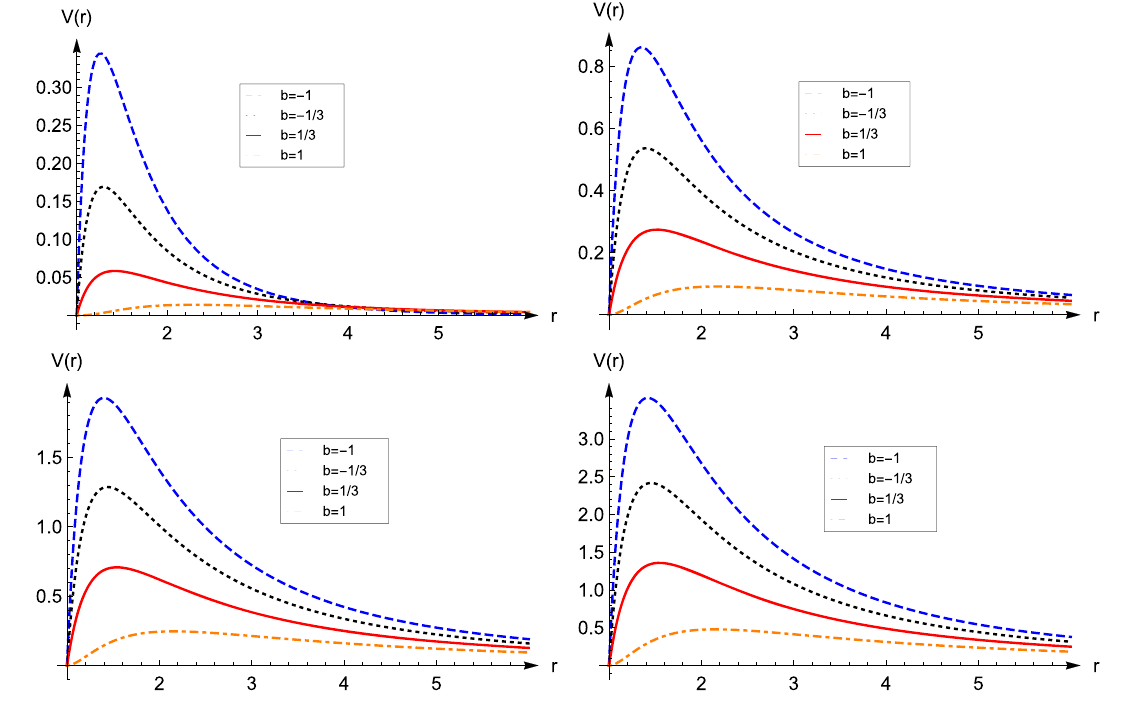
Fig. 11 V ( r ) versus r for L = 0 (up-left panel), L = 1 (up-right panel), L = 2 (down-left panel) and L = 3 (down-right panel)